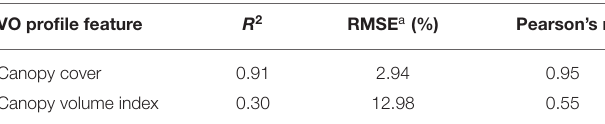
TABLE 2 | Correlation comparison between Virtual Orchard (VO) features of canopy cover, and canopy volume index to mobile lightbar platform (both on June 26) estimated fractional PAR (fPAR) at the per-row